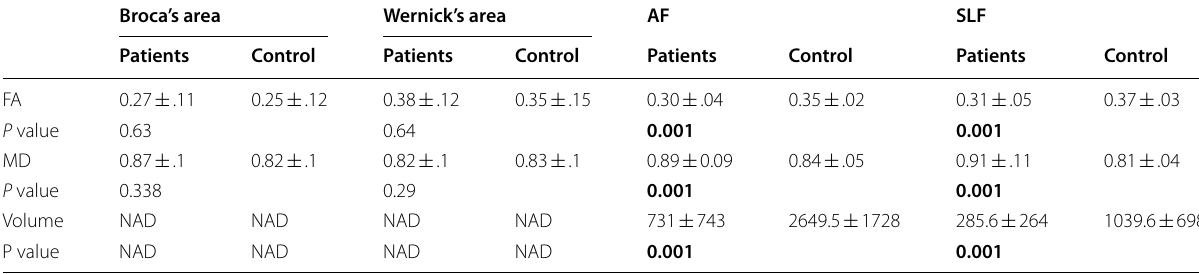
Table 1 Mean, standard deviation of FA and MD (10 − 3 mm 2 /s) and volume between patients and control Broca’s area